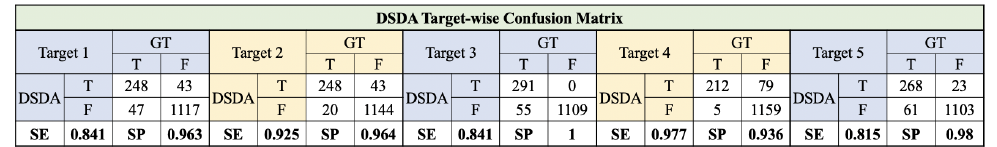
Figure 7. Target-wise Confusion Matrix to calculate sensitivity (SE) and specificity (SP) between DSDA and the ground-truth (GT) on the validation split of the IDRad Dataset (T: True, F: False).